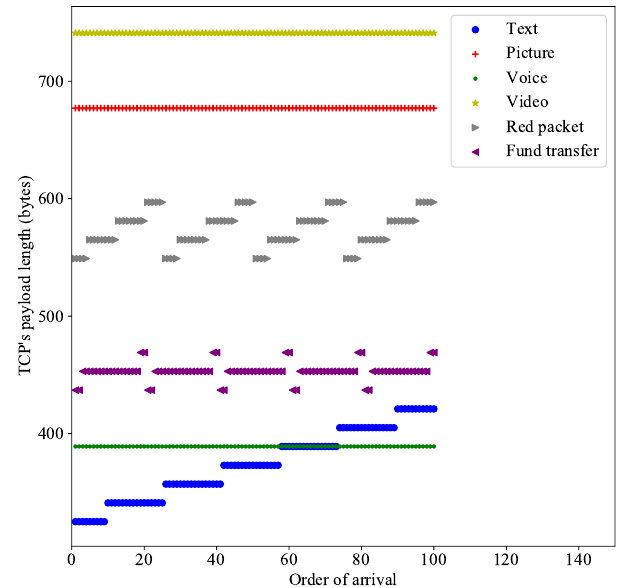
Figure 6. Length distribution of WeChat